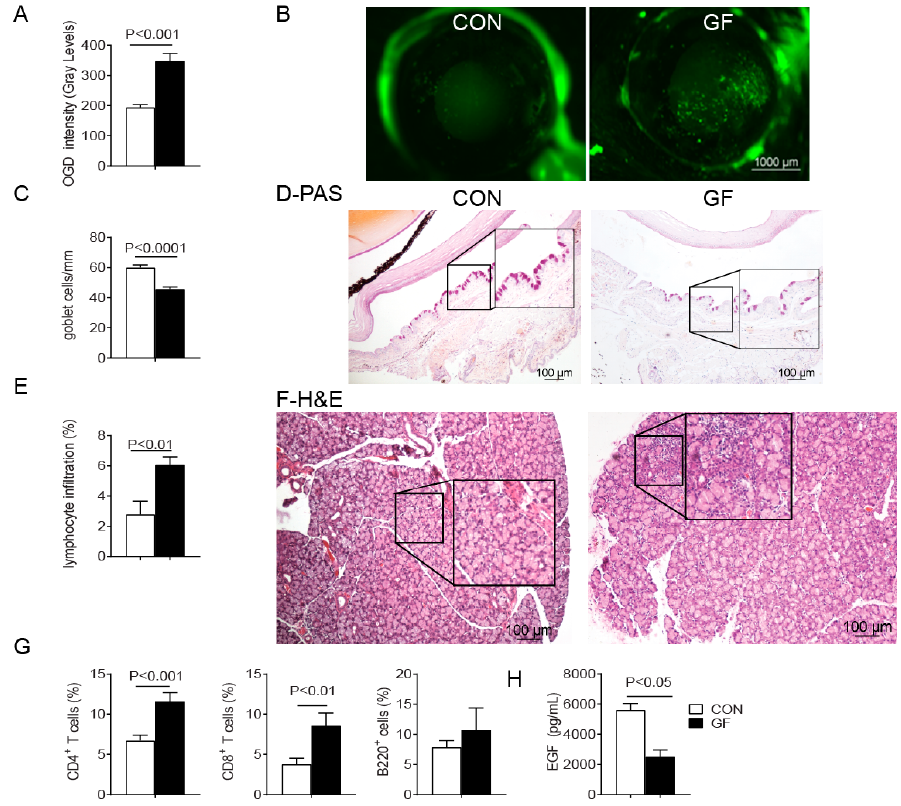
Figure 1. Sjögren-like Lacrimal Keratoconjunctivitis on germ-free mice. Conventionally housed